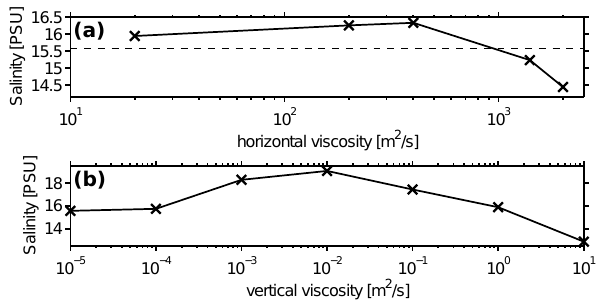
Fig. 15. Maximum near-bottom salinity at station BY5 in the period 9 January to 18 April 1993. Figure 15. Maximum near-bottom salinity at station BY5 in the pe- Panel (a) and (b) show maximum simulated salinities as function of horizontal and vertical riod 9 January to 18 April 1993. Panel (a) and (b) show maximum Laplacian viscosity, respectively. The dashed black line in panel (a) shows the maximum salinity simulated salinities as function of horizontal and vertical Laplacian simulated with the “standard” horizontal Laplacian viscosity of 0. Observed salinities peak at viscosity, respectively. The dashed black line in panel (a) shows the 18.5PSU (Fig. 11b). maximum salinity simulated with the “standard” horizontal Lapla- cian viscosity of 0. Observed salinities peak at 18.5PSU (Fig. 11b).